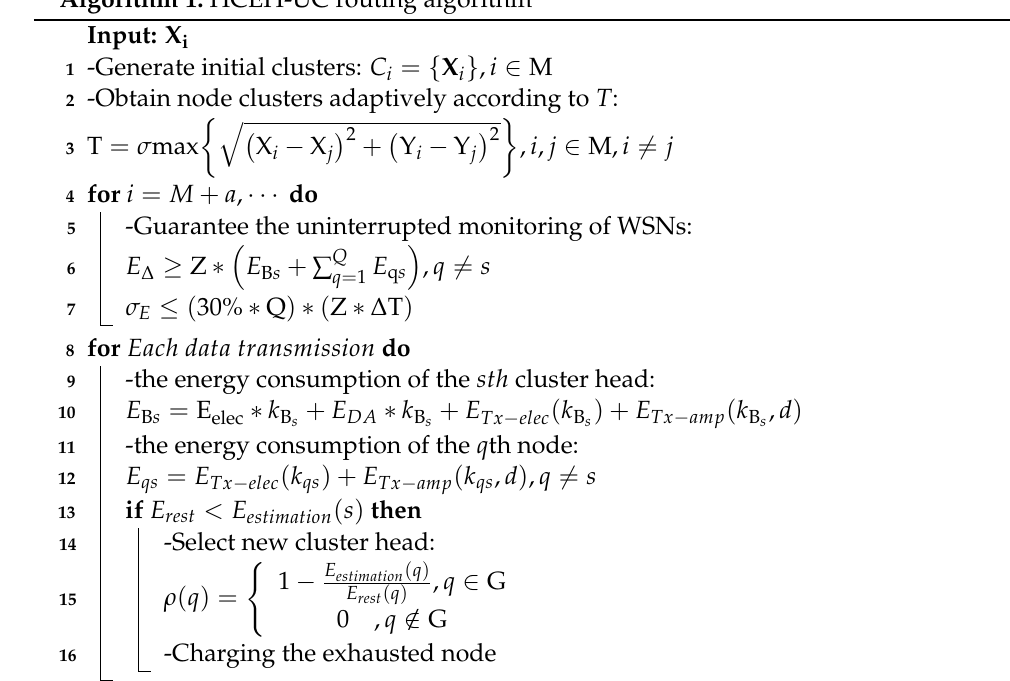
Algorithm 1: HCEH-UC routing